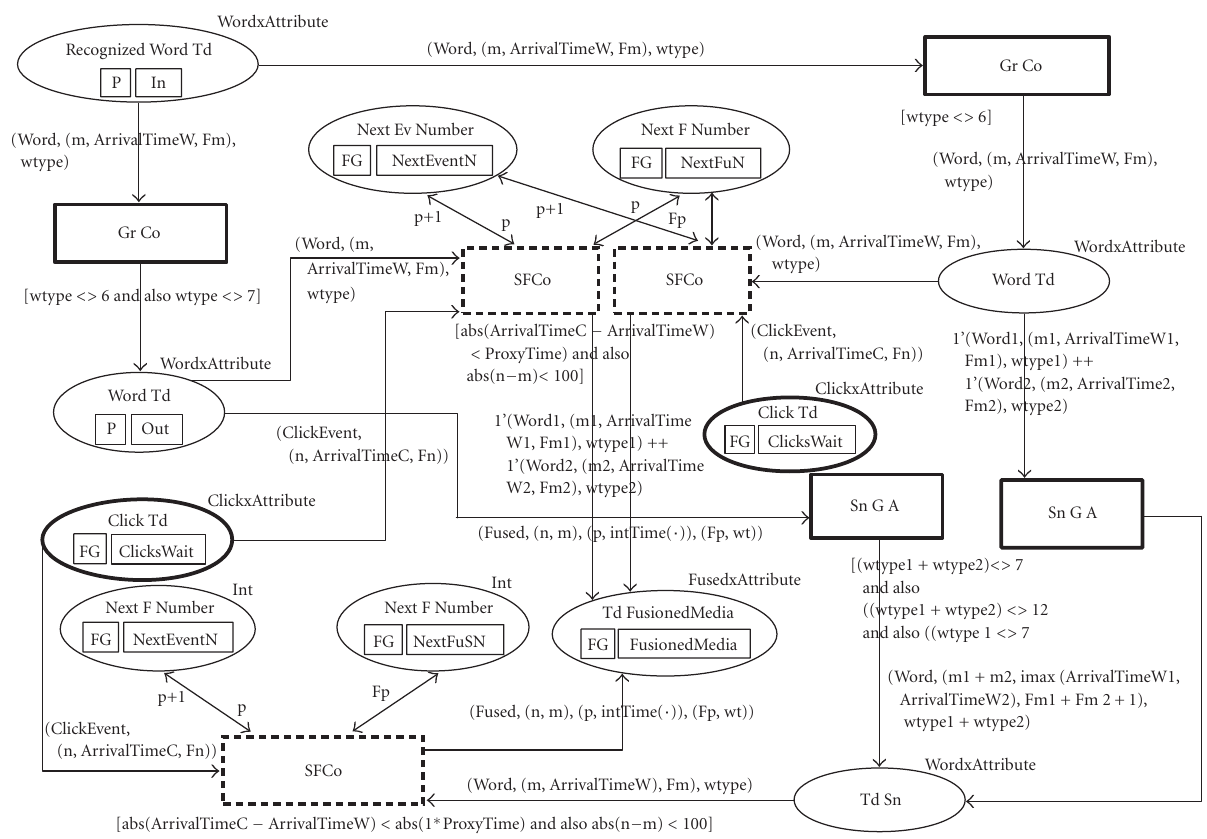
Figure 9: Sublevel of the bimodal fusion dialog: the functions used, intTime( · ) and imax( · ), return the current time and maximum integer value, respectively (A: agent, Co: component, F: fusion, G: generation, Gr: grammar, L: language, S: semantic, Sn: sentence, and Td: thread). pen stroke or lip movement recognition device,